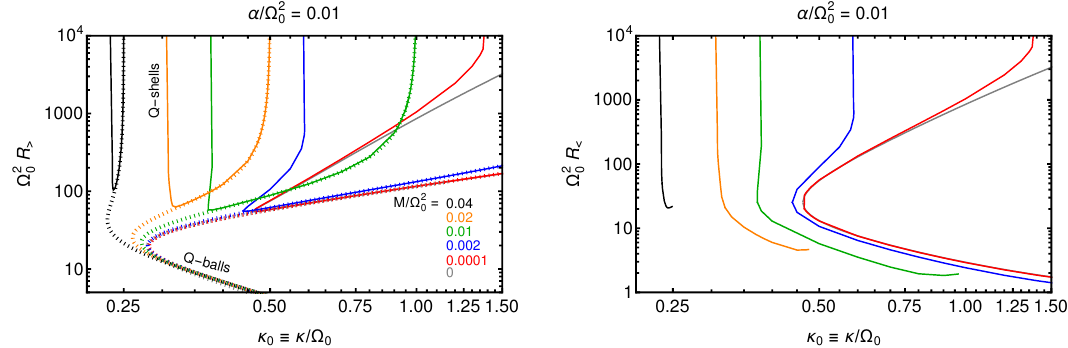
Figure 4 . Predictions for the Q-shell radii R > (left) and R < (right) based on eqs. (4.4) and (4.5) for several values of the gauge-boson Proca mass M . The narrow Q-shell radii R >,< diverge at κ given by eq. (4.6); the wide Q-shell radii R > are degenerate with the Q-ball radii (dashed) and both end at a radius that is determined by eq. (2.25) for a given Ω 0 , not shown in the